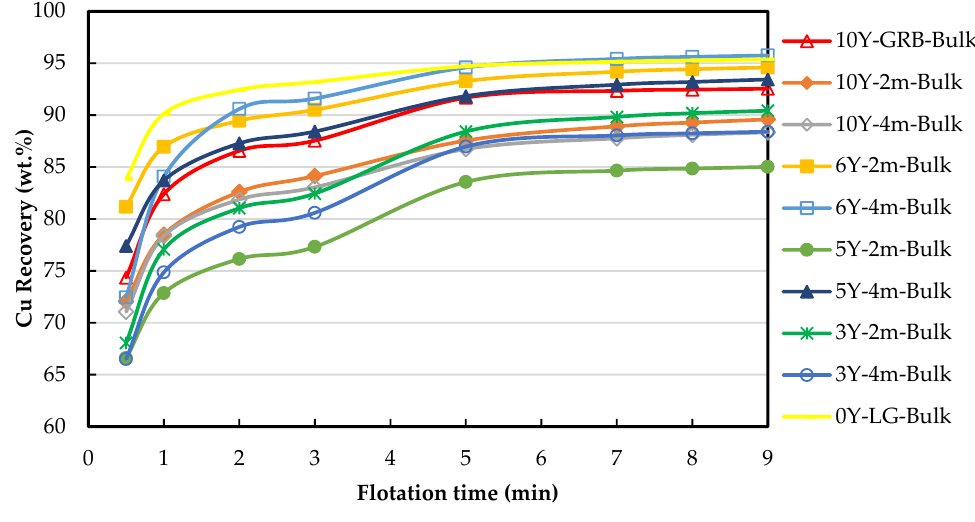
Figure 14. Kinetic rougher tests for all bulk samples.